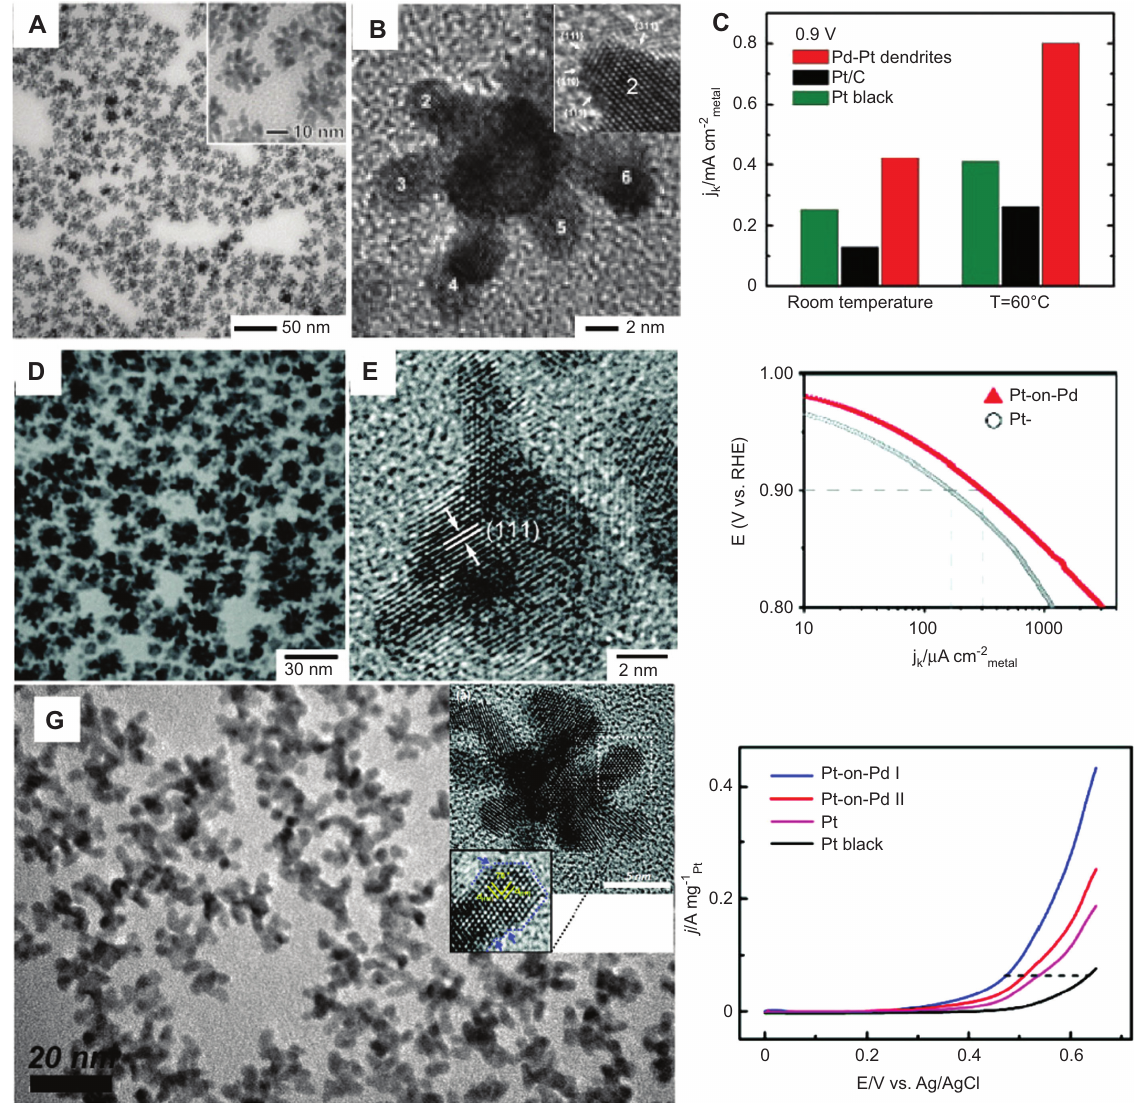
Figure 3 (A–C) Pd-Pt bimetallic nanodendrites and specific activities for ORR. Adapted with permission from Ref. [35]. Copyright